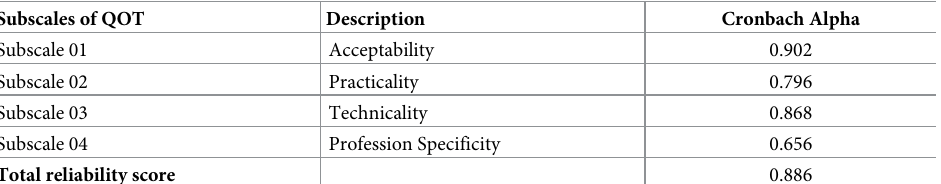
Table 4. Results of internal reliability